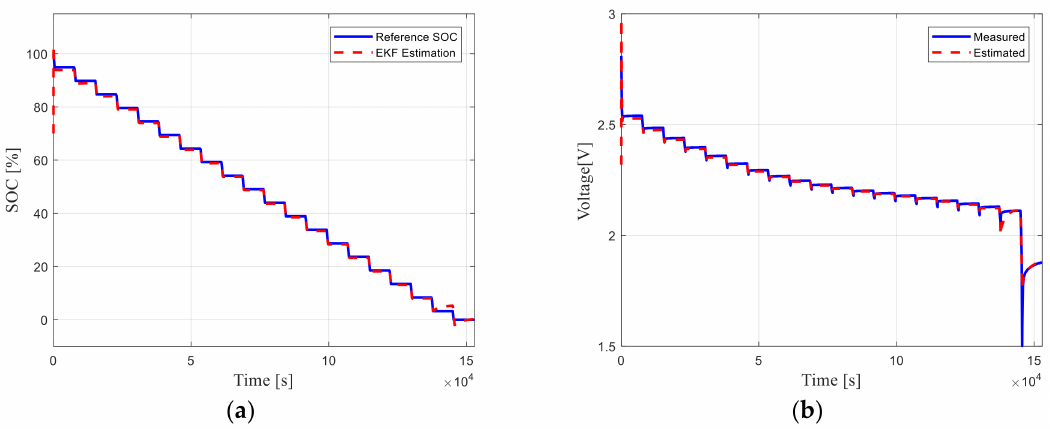
Figure 11. ( a ) SOC estimation results at 25 ◦ C when the initial SOC is set to 70%; ( b ) Comparison between measured and estimated voltage 25 ◦ C.